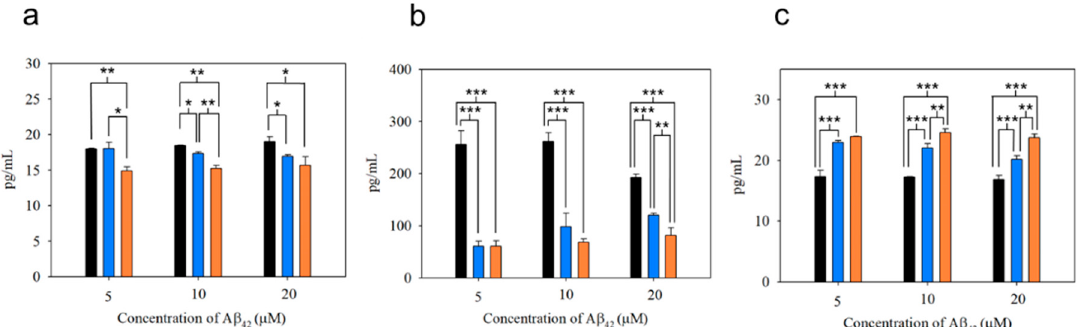
Figure 8. Cytokine secretion from BV-2 cells treated with oA β 42 , mpA β 42 , and npA β 42 , respectively, for 6 h. Concentrations of IL-1 β ( a ), TNF- α ( b ), and IL-10 ( c ) were determined in triplicate wells by ELISA analyses. The experiments were independently repeated three times and one-way ANOVA was used to examine the mean di ff erences between the data groups. *** p < 0.005, ** p < 0.01, * p < 0.05, and N.S. p > 0.05. Error bars represent mean ± s.d. ( n = 3).